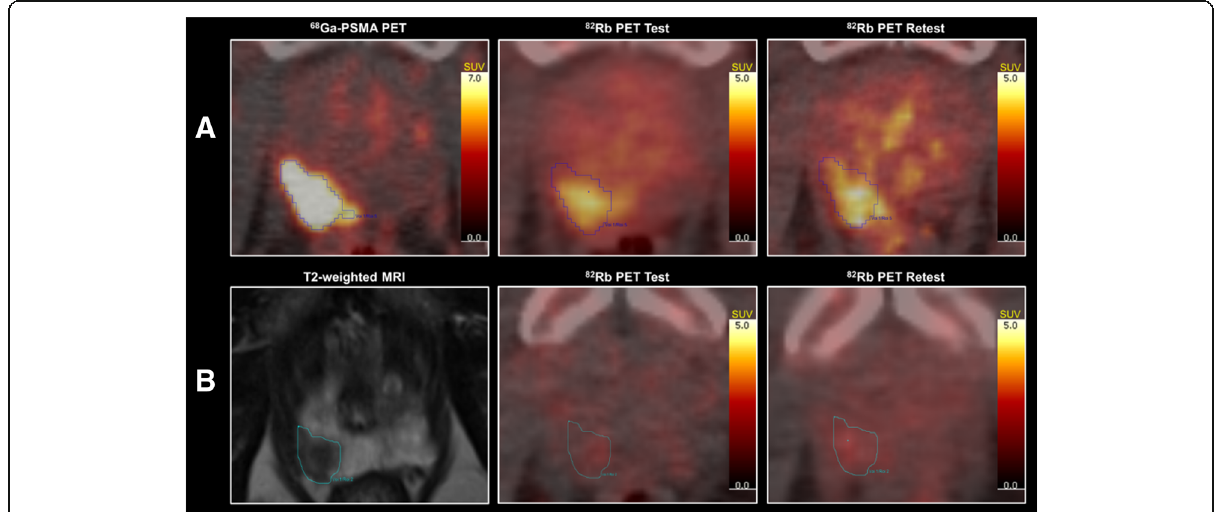
Fig. 1 Images of two patients in the study. a Patient 2, a high-risk patient with a Gleason 5+4 high-flow tumor and metastatic disease. To the left, 68 Ga-prostate-specific membrane antigen (PSMA) positron emission tomography (PET)/computed tomography (CT) with automatically drawn volumes of interest (VOIs) from standard uptake value (SUV) 6 fixed threshold in blue. The first 82 Rb PET/CT scan in the middle and the second scan to the right. b Patient 9, a low-risk patient in active surveillance with a low-flow tumor. To the left, t2-weighted magnetic resonance imaging with hand-drawn VOIs in light blue. The first 82 Rb PET/CT scan in the middle and the second scan to the right